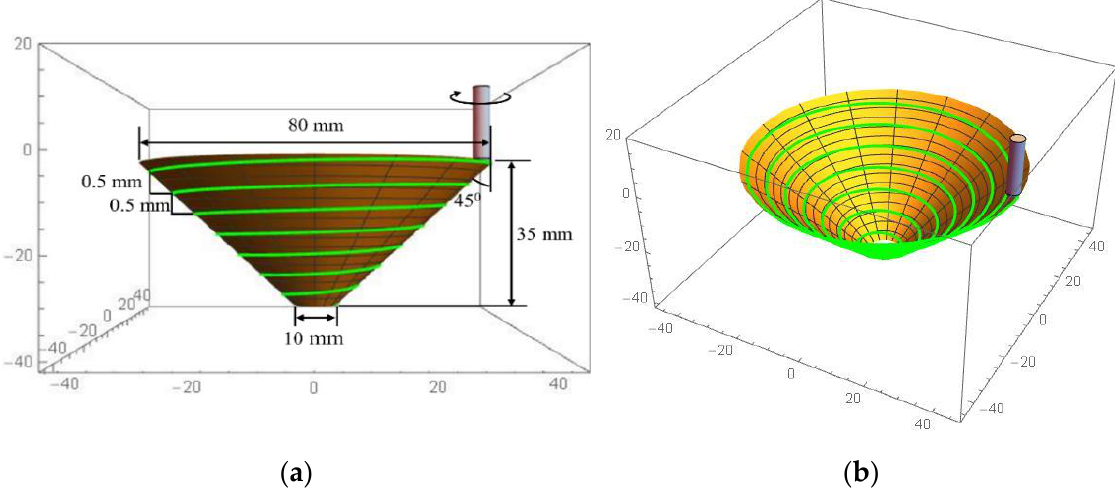
Figure 1. ( a ) CAD geometry and dimensions of the experimental product and ( b ) view of an inward spiral path.